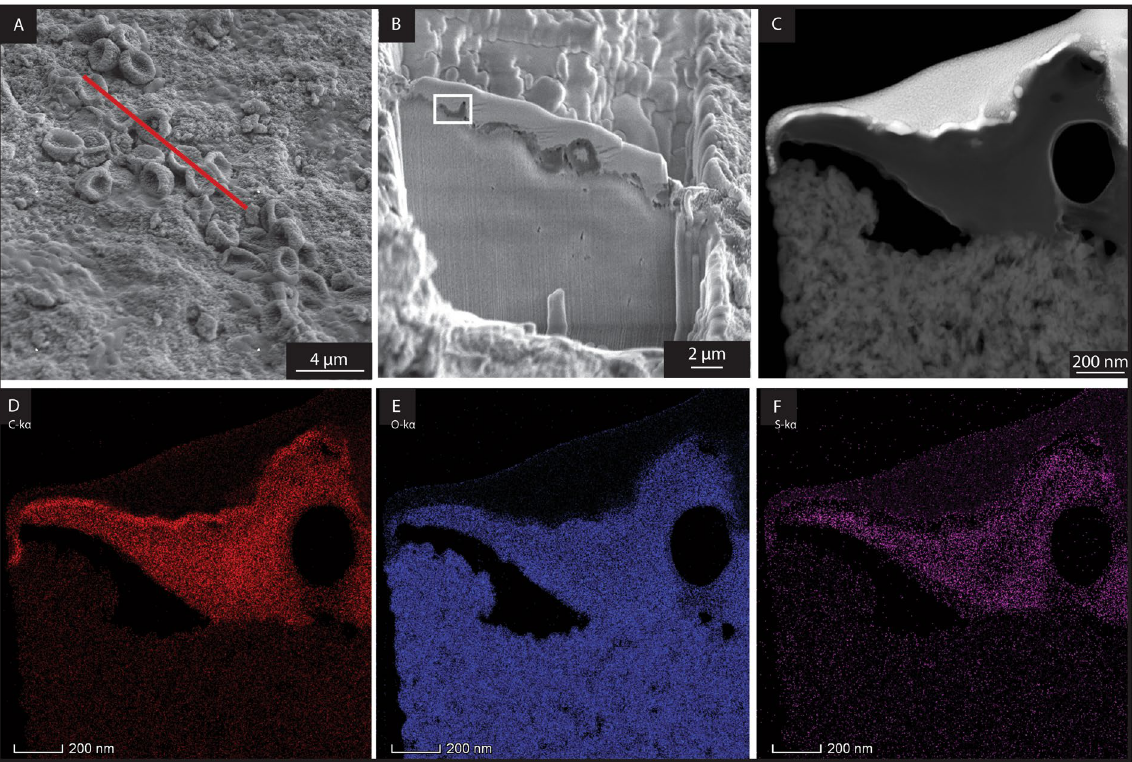
Figure 4. Area extracted by FIB-SEM for TEM analysis. ( A ) Secondary electron image of the trabecular bone showing the presence of RBC-like structures. The TEM foil was extracted from a cross-section showed by the red line. ( B ) Secondary electron image taken during TEM foil preparation showing the cross-section of the foil just prior to lift-out. The white rectangle indicates the area selected for TEM elemental mapping in ( D , E and F ). ( C ) TEM-HAADF image of a RCB-like structure. ( D ) Carbon (C) distribution of the RCB-like structure by TEM. ( E ) Oxygen (O) distribution of the RCB-like structure. ( F ) Sulfur (S) distribution in the RBC-like structure.